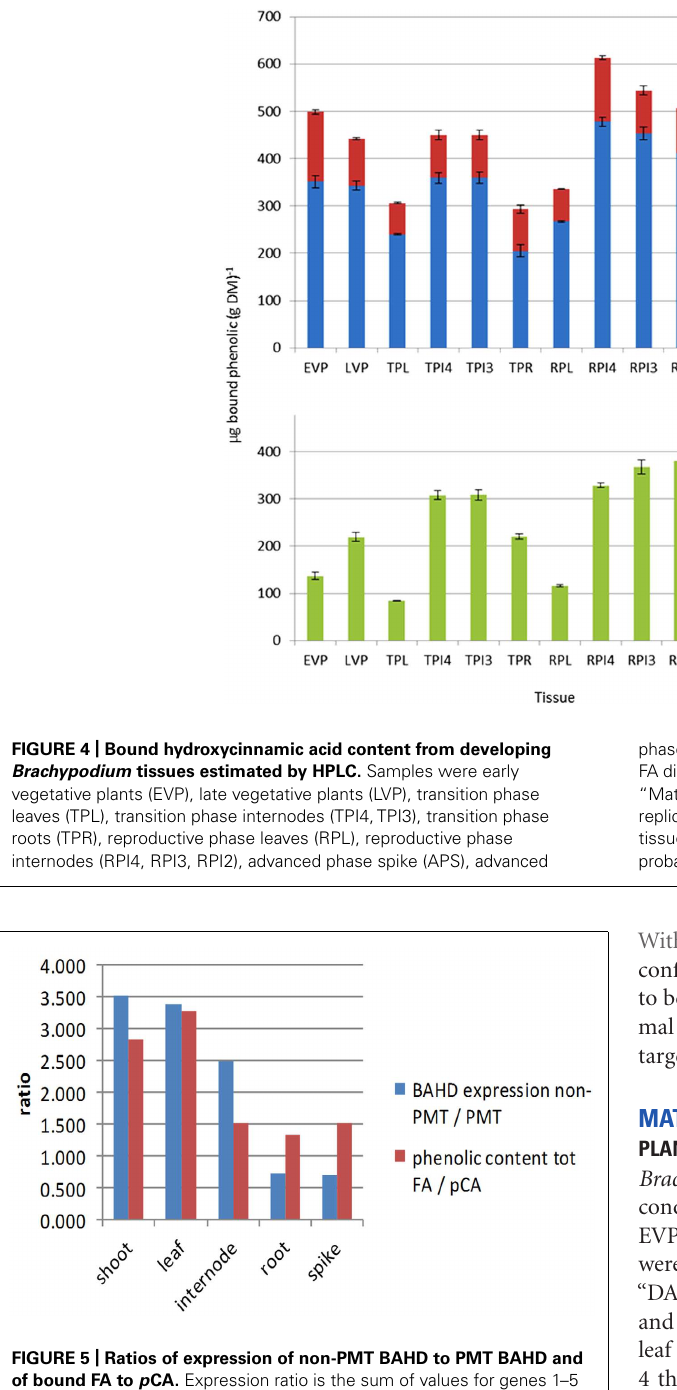
FIGURE 5 | Ratios of expression of non-PMT BAHD to PMT BAHD and of bound FA to p CA. Expression ratio is the sum of values for genes 1–5 and 8 (non-PMT) relative to the sum of values for genes 7 and 9 (PMT). FA to pCA ratio is the sum of FA monomer and dimers relative to p CA. Ratios shown are averaged over EVP, LVP for shoots,TPL, RPL for leaves,TPI4, RPI4, RPI3, RPI2 for internodes; root isTPR and spike is APS.